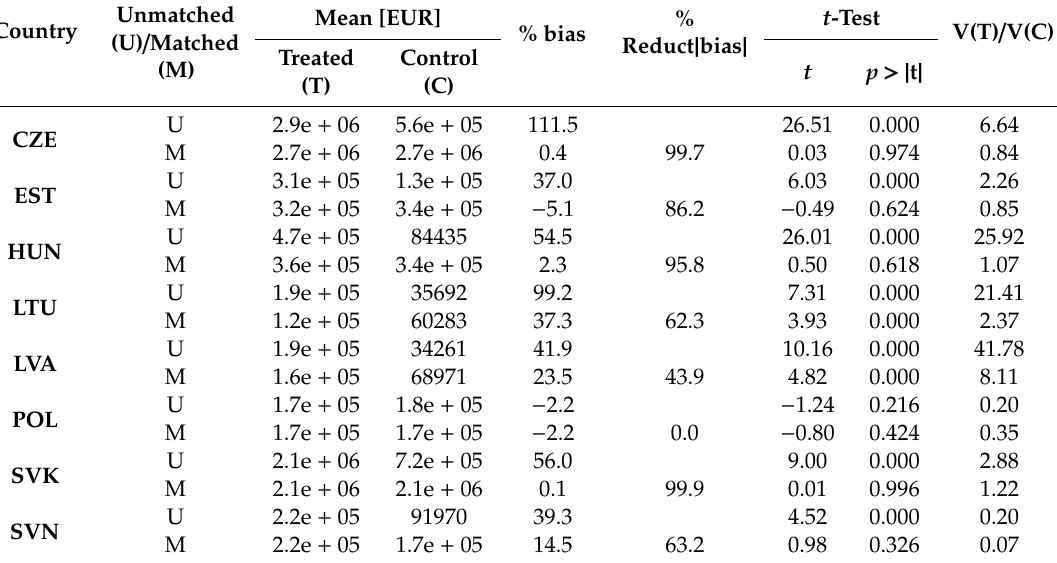
Table 4. Results of the matching procedure for the variable “capital” (in EUR, SE441-SE446).